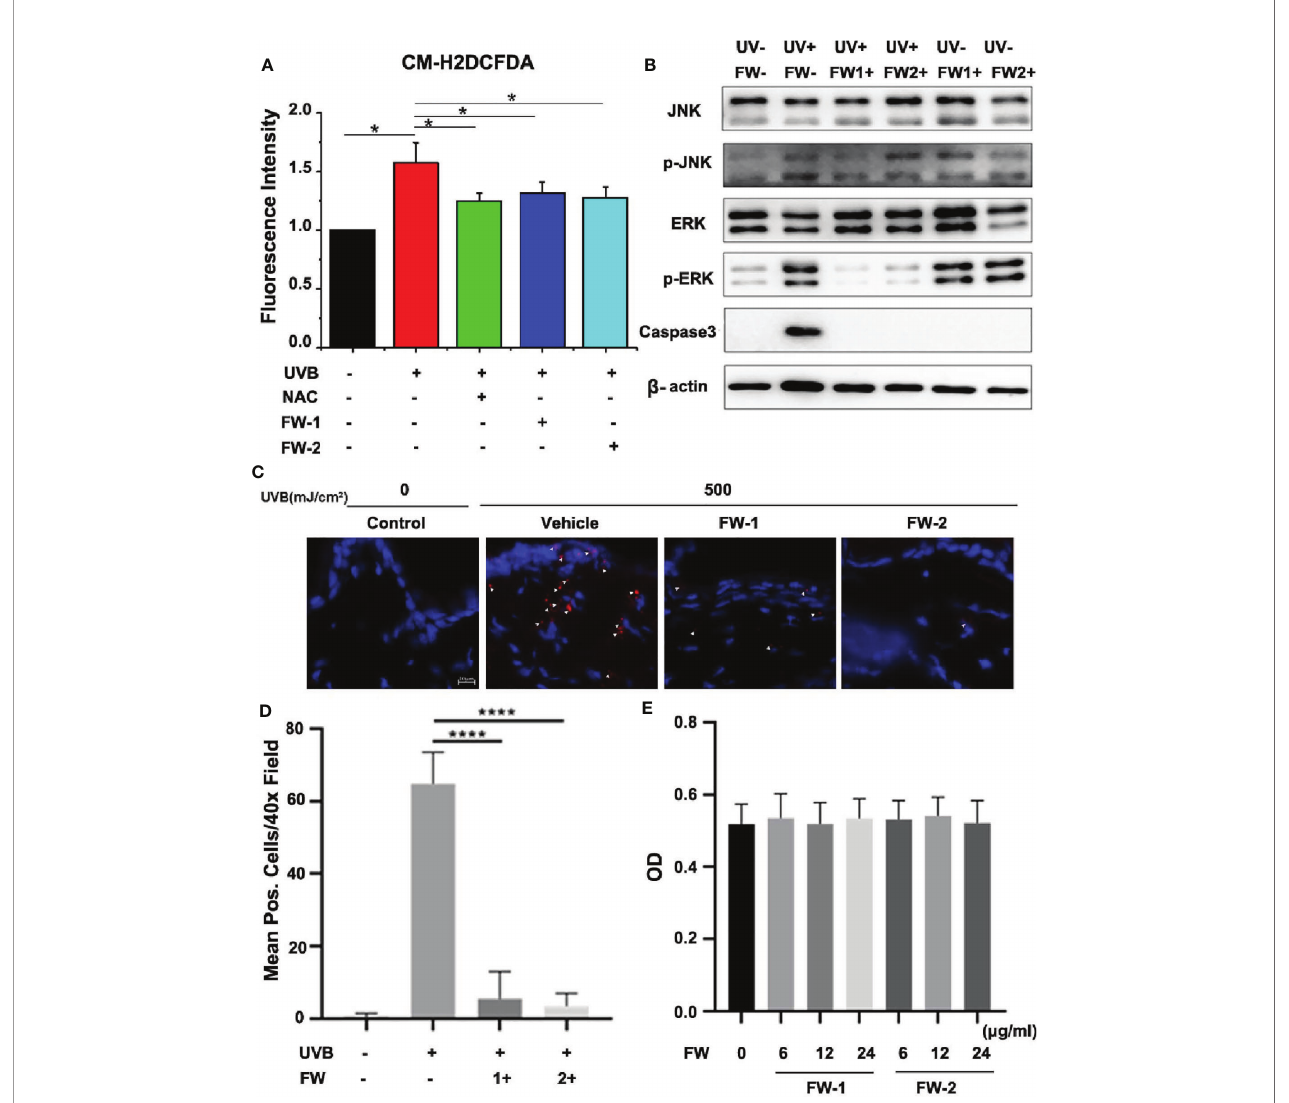
FIGURE 5 | FW-1 and -2 inhibit ROS accumulation in UV-irradiated keratinocytes. (A) HaCaT cells with or without FW-1 and -2 (12 m g/ml) pre-treatment were irradiated with 10 mJ/cm 2 UVB. FW-1 and -2 or positive control NAC (5 mM) was added 1 hr before UVB exposure. After irradiation, ROS levels were measured using a microplate reader (n=3). Error bars represents mean ± S.D. *P < 0.05. (B) HaCaT cells with or without FW-1 and -2 (12 m g/ml) pre-treatment were exposed to UVB radiation (10 mJ/cm 2 ) and incubated for 4 hr. The cell lysates were then immunoblotted with the indicated antibodies. (C) Skin tissues of mice with or without FW-1 and -2 treatment were obtained after 48 hr post UV exposure (500 mJ/cm 2 UVB). Skins were sectioned and processed for anti-cleaved caspase 3 immunostaining (red). The arrowheads mark the positively stained cells. The blue signals indicate nuclear staining. Scale bars, 10 m m. (D) Quanti fi cation of stained cells per high power fi eld from skins in (C) ****P < 0.0001. (E) HaCaT cells treated with FW-1 and -2 at different doses relevant to our studies were exposed to UVB radiation (10 mJ/cm 2 ) and incubated for 18 hr later for cytotoxicity analysis using MTT Cell Proliferation and Cytotoxicity Assay Kit. No signi fi cant differences were detected between groups (n=3). P >